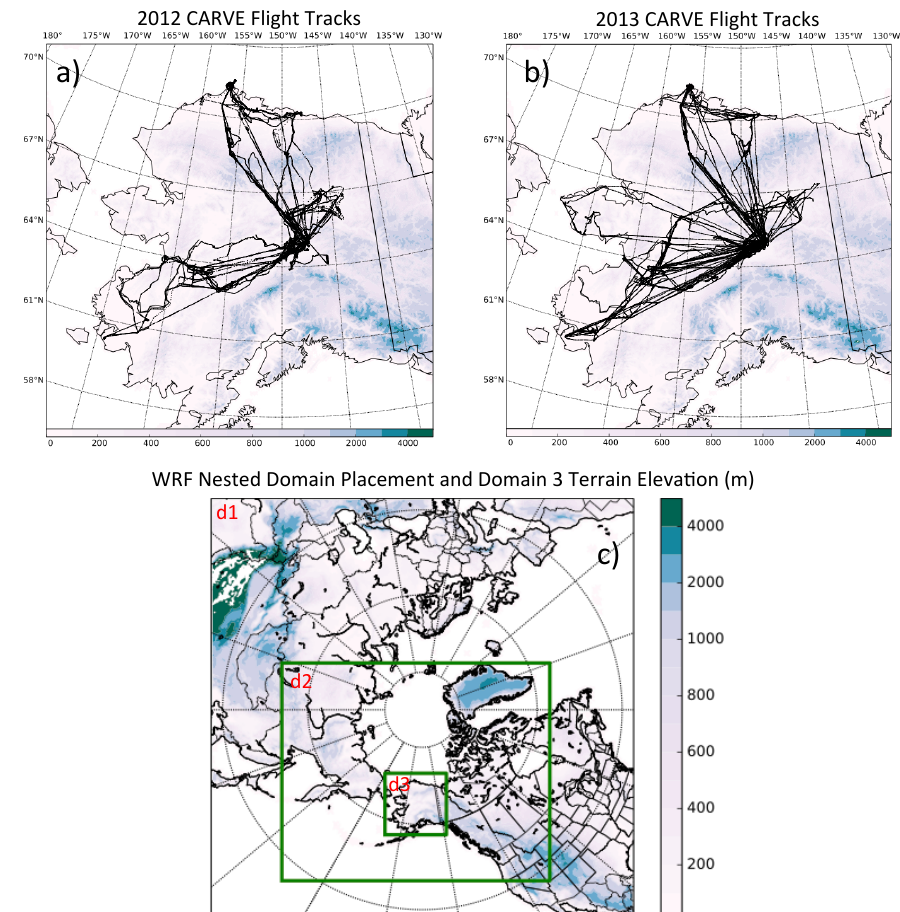
Figure 2. CARVE flight tracks from (a) 2012 and (b) 2013 superimposed on WRF innermost domain 3, and (c) placement of nested WRF domains used for CARVE modeling, with model topography field (shaded, m) for outermost domain 1 (30km grid spacing). Nested subdo- mains are shown by green rectangles: domain 2 (d2) with 10km grid spacing covers eastern Russia and western Canada, while innermost domain (domain 3, d3, 3.3km grid spacing) covers mainland Alaska. Innermost domain model topography field (shaded, m) is shown in (a) and (b)